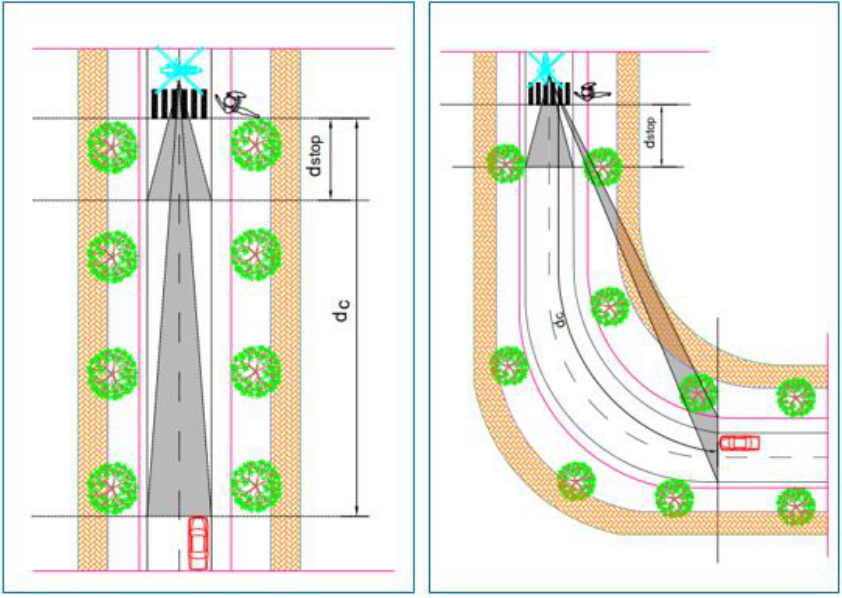
Figure 2. Our considered scenario: crosswalk controlled by drone. ( left ) The car comes through a straight line. ( right ) The car comes through a curved